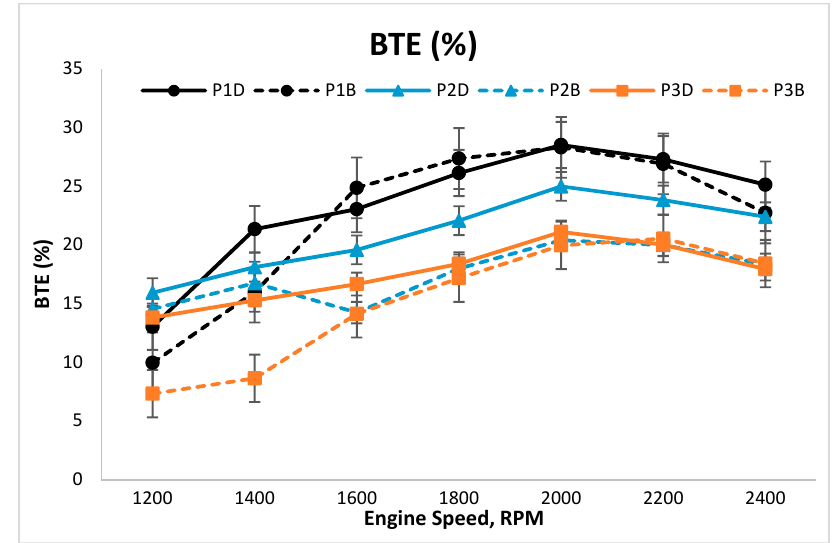
Figure 16. BTE percentage at variable engine speeds.